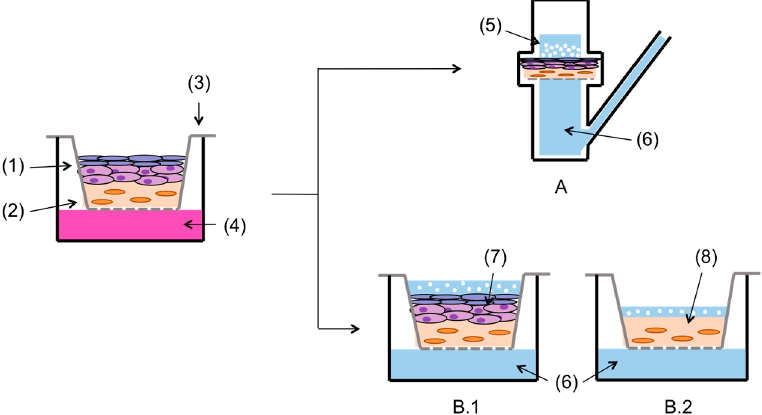
Figure 1. Full thickness skin substitute consisting of epidermal (1) and dermal (2) tissues was cultured on cellular inserts (3) using human primary keratinocytes (hKCs) culture medium (4). For permeation tests, the base of the cellular insert with full thickness skin was placed as separator membrane in Franz cells ( A ), usingraw lidocaine hydrochloride (LID) or drug-loaded GMS-LID4 particles (5) in the donor compartment. The release medium was PBS pH 7.4 (6). Another part of the experiment tested the permeation of LID from GMS-LID4 particles directly in the cellular inserts, using ( B.1 ) either full thickness skin substitute (7) containing the keratinocyte layer, ( B.2 ) or dermal tissue (8) without epidermis as membrane.